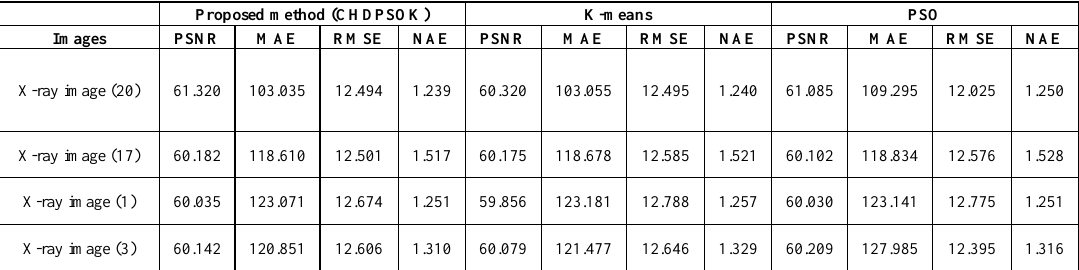
Table 3. Comparison of the proposed approach with standard k-means algorithm on lung segmented images. Proposed method (CHDPSOK) K-means PSO Images PSNR MAE RMSE NAE PSNR MAE RMSE NAE PSNR MAE RMSE NAE X-ray image (20)